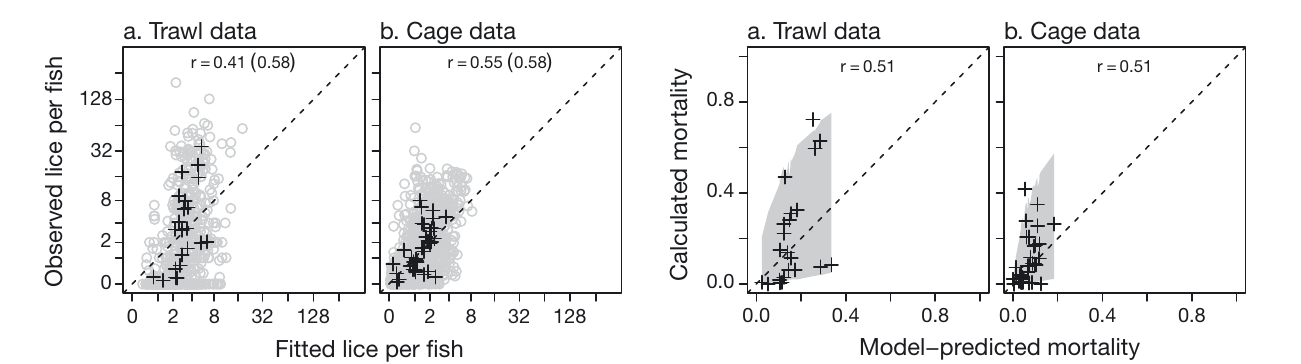
Fig. 3. Fitted and observed number of salmon lice per fish in the (a) trawl and (b) sentinel cage data. Fitted values refer to the main model. Grey circles: mean lice per fish in one sam- ple (trawl haul or sentinel cage experiment); crosses: mean for one management area and year. Pearson’s correlation coefficient (r) between predictions and observations is cal- culated at the scale log 10 (x + 1) at the sample level and at the area−year level (numbers in parentheses). Dashed lines